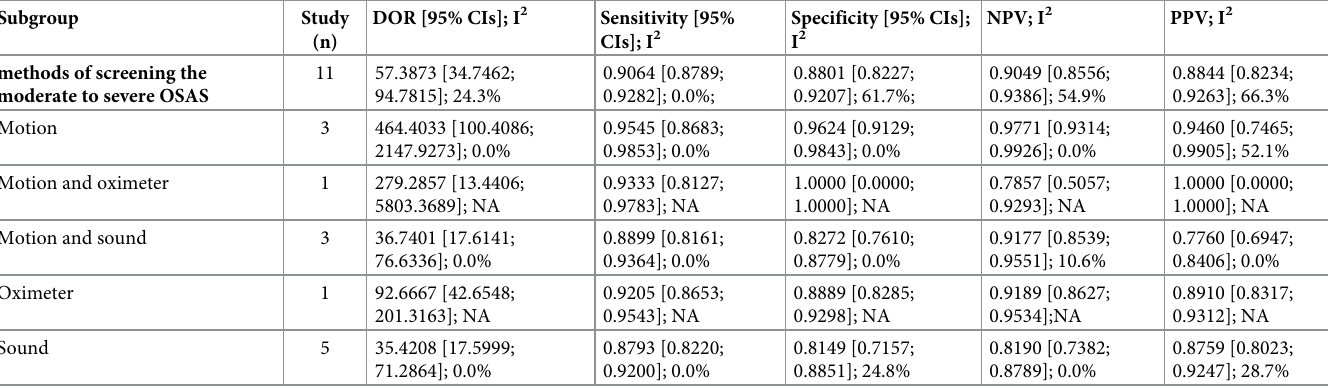
Table 1. Subgroup analysis according to detection